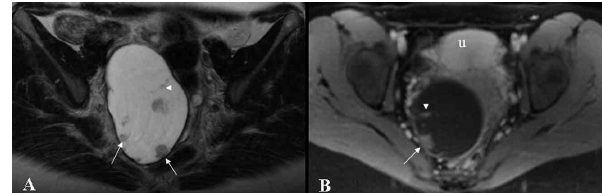
Figure 5 - Follow-up pelvic MR exam. Axial TSE T2-weighted (A) and post-contrast axial GRE T1-weighted (B) images show a retrouterine, large, well-delimited cystic lesion with internal post-contrast-enhanced nodules (arrows) and partial septations (arrowhead). This lesion was surgically ex- cised and histopathologically confirmed as to be a recidivate mesothelioma (u,